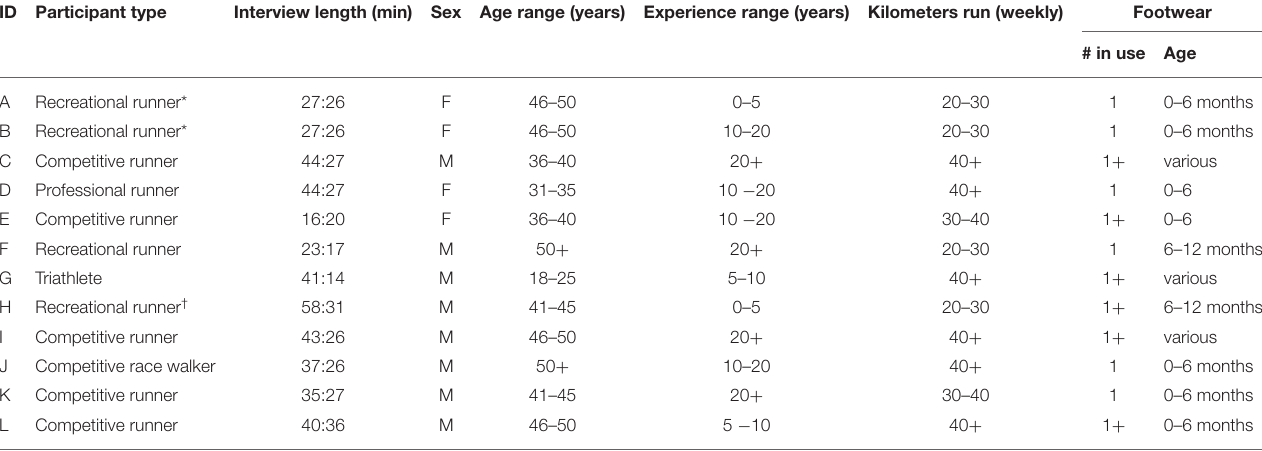
TABLE 1 | Runner characteristics.